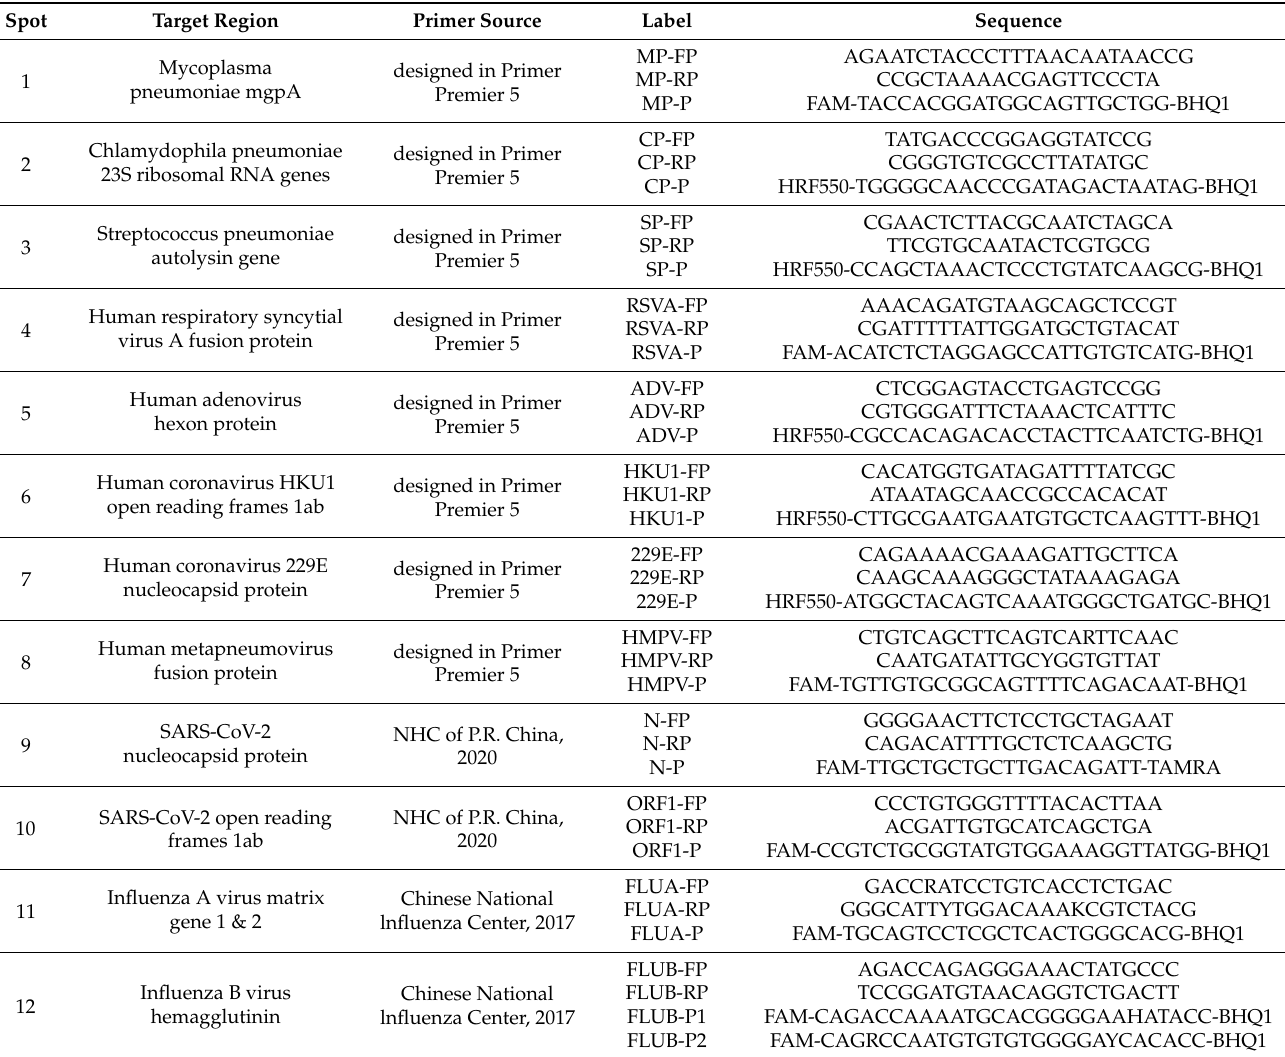
Table 1. RT-qPCR primers and probes used in the